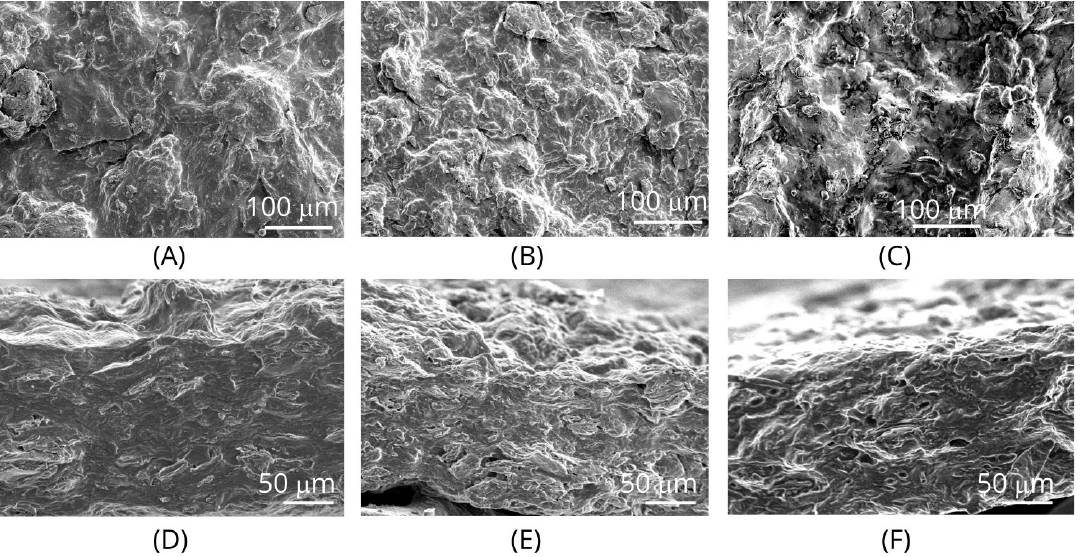
Figure 3. SEM micrographs of films: ( A ), ( B ), and ( C ): surfaces of films #1, #2, and #3 respectively; ( D ), ( E ), and ( F ): cross-sections of films #1, #2, and #3 respectively. Table 1. Properties of films from different formulations and regression coefficients (in pseudo-com- ponents).